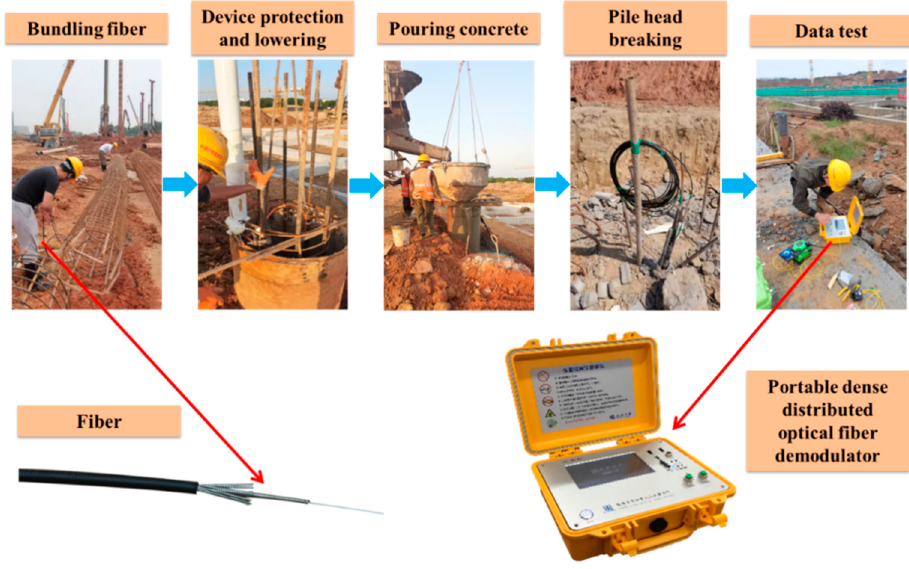
Figure 3. Main steps of deformation test.